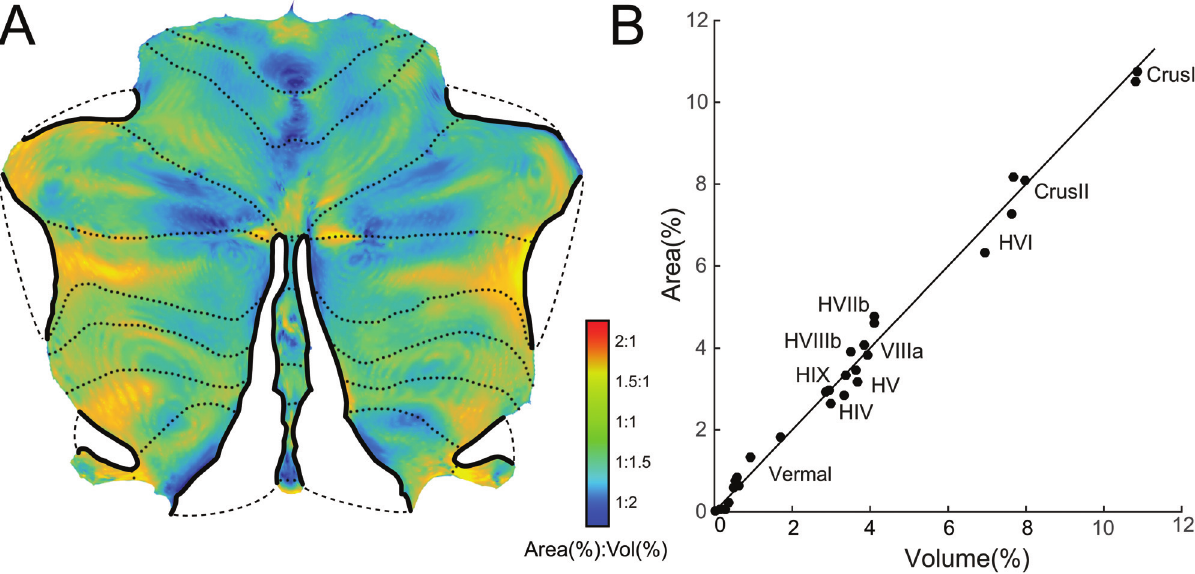
Fig 3. Distortion of the flatmap in representing cerebellar grey-matter volume as surface area. ( A ) Flatmap with superimposed distortion factor (ratio of Area to Volume). Orange / red areas indicate regions that are disproportionally large on the flatmap, turquoise / blue areas indicate regions that are disproportionally small. Dotted lines indicate boundaries between lobules. Thick black lines on the perimeter indicate where cuts have been made to the map. The areas connected with dashed lines are immediately adjacent in the volume, but are unfolded in the flatmap to minimize distortion. ( B ) Volume of each lobule (in % of total grey-matter volume) plotted against the corresponding area on the flatmap (in % of total map area). Plotted are 28 compartments, hemisphere and vermis of each of the main lobules, as defined in the probabilistic atlas of the human cerebellum.